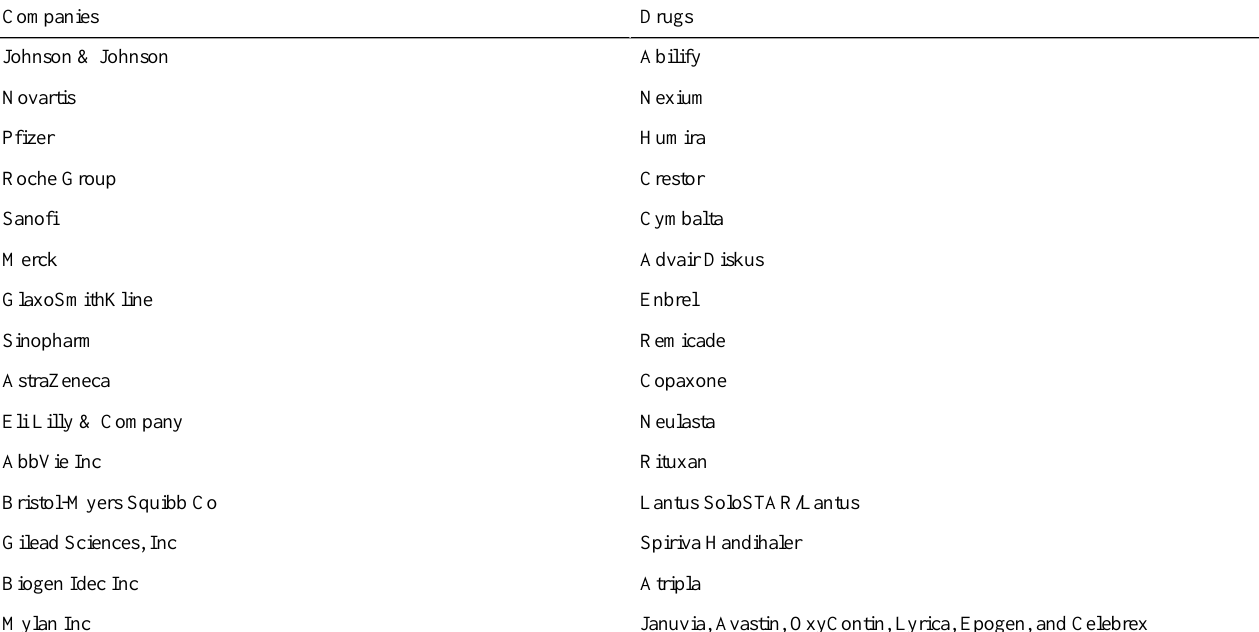
Table 1. Pharmaceutical companies and drugs